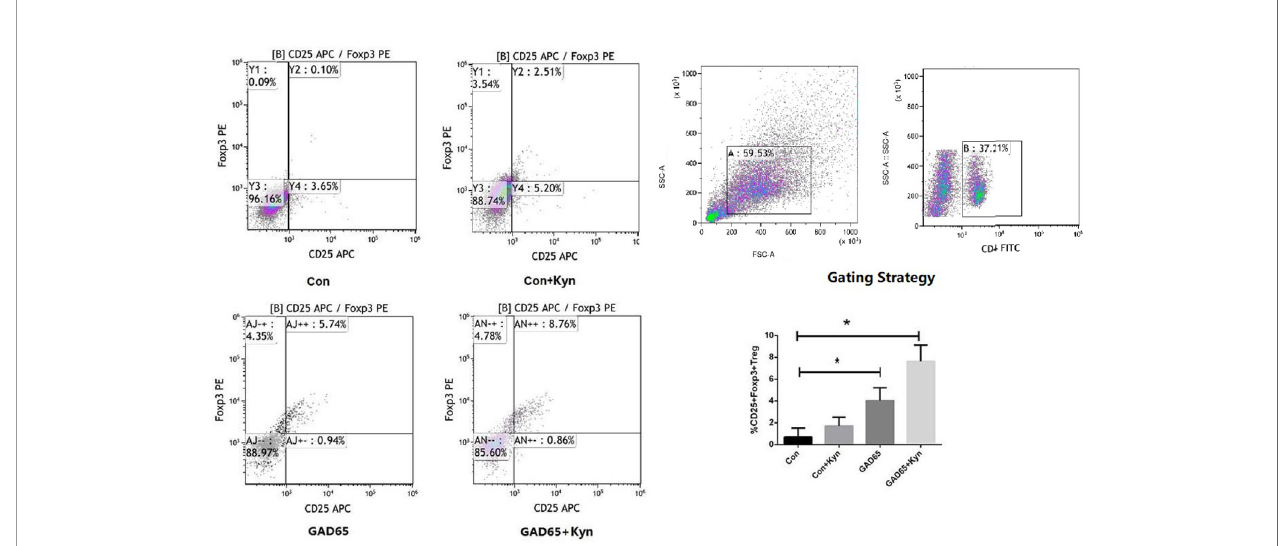
FIGURE 6 | Kyn induced CD4 + CD25 + Foxp3 + Treg cells. At the 16th week, mice spleen lymphocytes were stained and immediately analyzed on Flow Cytometer. Notably, Kyn still strongly enhanced the percentages of CD4 + CD25 + Foxp3 + Treg cells when co-immunized with GAD65 phage vaccine (*P <